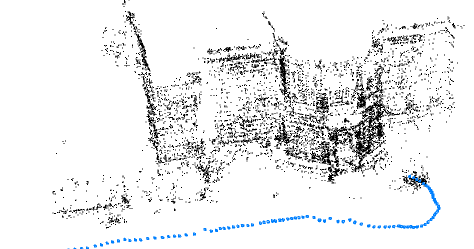
Figure 5: Illustration of the estimated scene points and poses of the right stereo camera images.